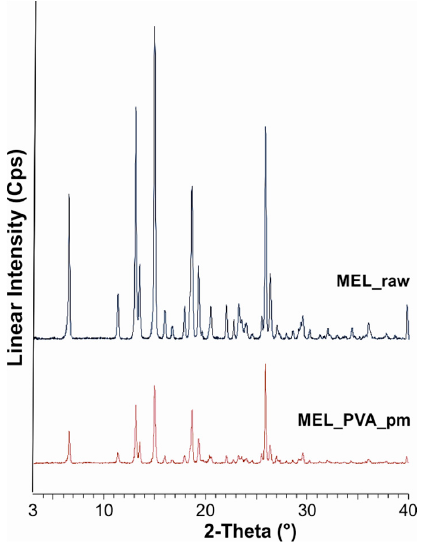
Table 3. The degree of MEL crystallinity (%) for different dispersant media and milling times.